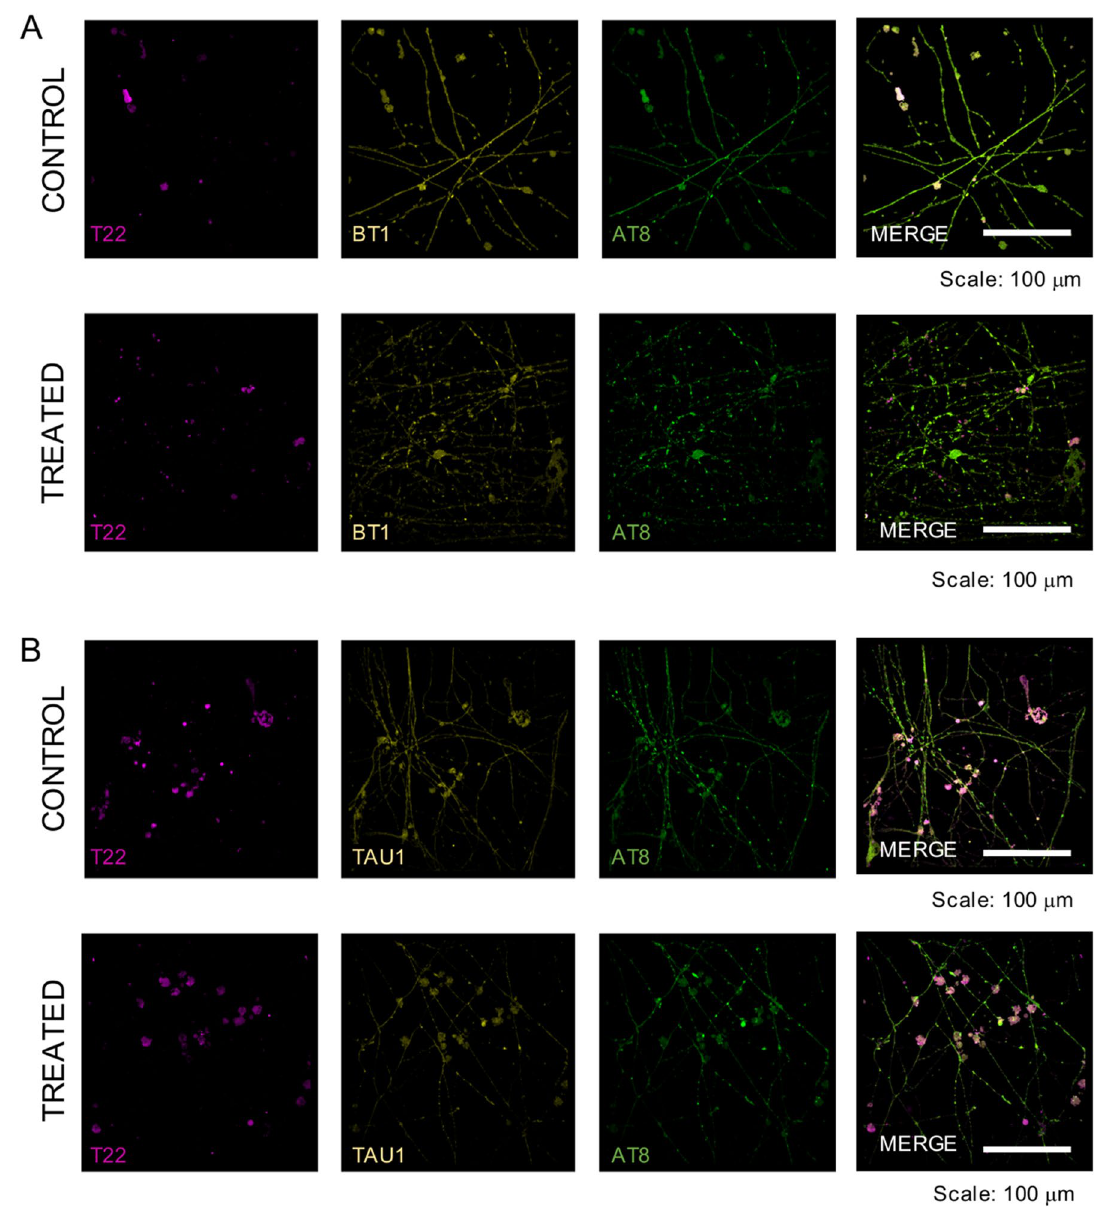
Figure 5. BT1 and TAU1 staining of hyperphosphorylated tau in iPSCs derived cortical neurons. ( A ) Top: Representative fluorescence images of control human iPSC-derived cortical neurons at 30 days in vitro incubated with BT1 (100 μM) for 30 min at 37 °C and then stained for AT8 (green) and T22 (magenta). Bottom: Representative fluorescence images of human iPSC-derived cortical neurons treated with okadaic acid (50 nM) for 2 h before incubation with BT1 (100 μM) for 30 min at 37 °C and relative staining for AT8 (green) and T22 (magenta). Images were acquired on an Olympus iX73 microscope equipped with an X-Light V3 spinning disc head using a 40 × magnification. Scale bar: 100 µm. ( B ) Top: Representative fluorescence images of control human iPSC-derived cortical neurons at 30 days in vitro incubated with TAU1 (100 μM) for 30 min at 37 °C and then stained for AT8 (green) and T22 (magenta). Bottom: Representative fluorescence images of human iPSC- derived cortical neurons treated with okadaic acid (50 nM) for 2 h before incubation with TAU1 (100 μM) for 30 min at 37 °C and relative staining for AT8 (green) and T22 (magenta). Images were acquired on an Olympus iX73 microscope equipped with an X-Light V3 spinning disc head using a 40 × magnification. Scale bar: 100 µm. (ImageJ software bundled with Java 1.8.0_172 software; URL: https:// imagej. nih. gov/